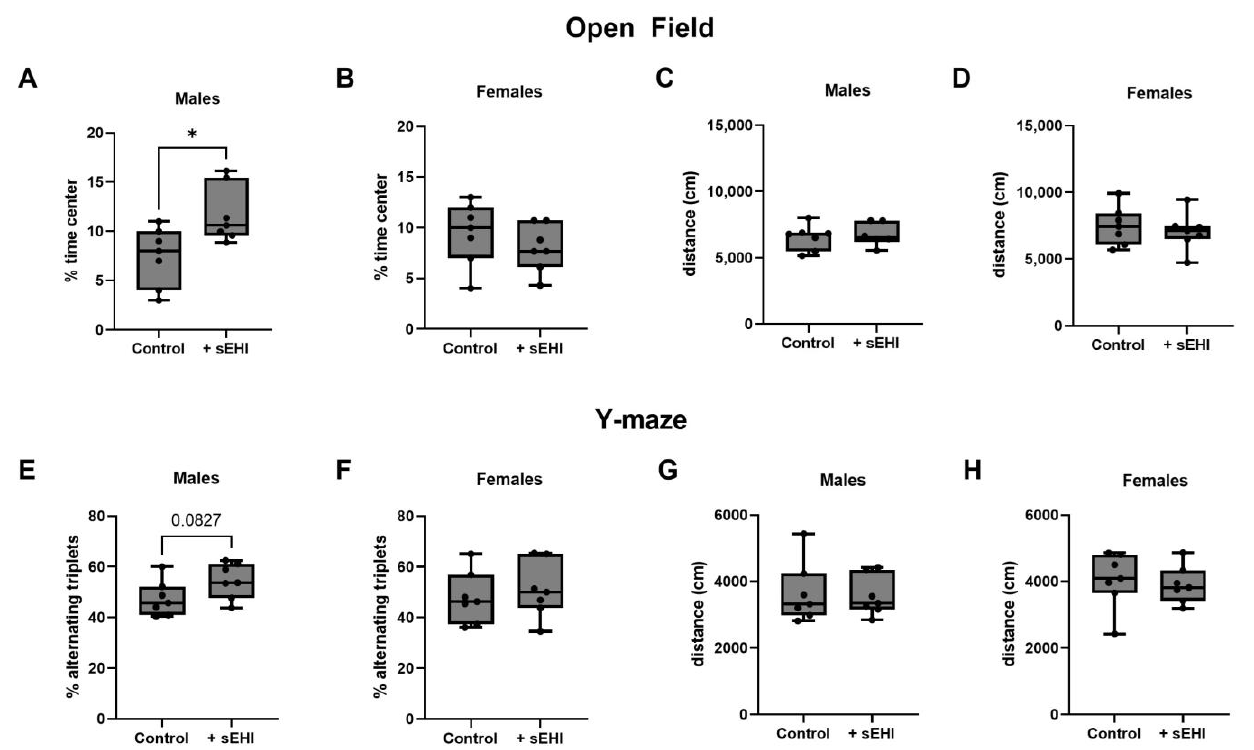
Figure 8. Behavioral and cognitive testing of sEHI-treated and control male and female mice. The percentage of time spent in the center of the open field test is shown for males ( A ) and females ( B ). The total distance traveled is shown for the open field test for males ( C ) and females ( D ). The percent alternating triplets during the Y-maze test is shown for males ( E ) and females ( F ). The total distance traveled is shown for the Y-maze for males ( G ) and females ( H ). The box extends from the 25th to the 75th percentile, with the middle line indicating the median. The whiskers extend to the minimum and maximum values, with individual values indicated by black dots. * p < 0.05.